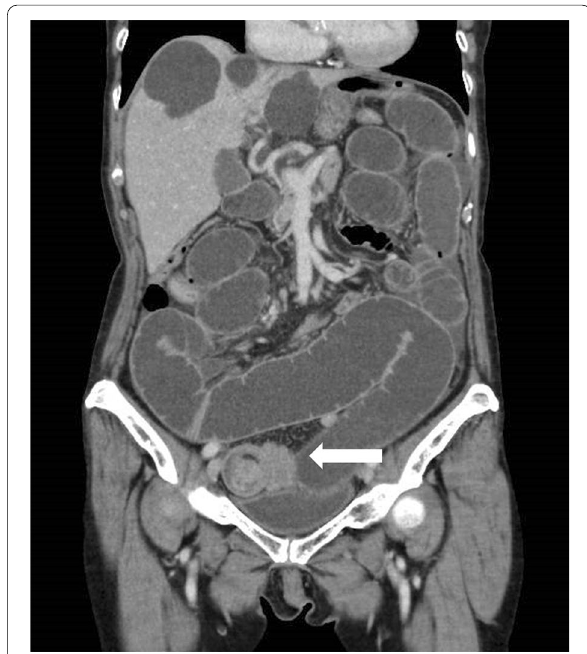
Fig. 1 Late-phase contrast-enhanced CT. Target sign is detected in the small intestine in right lower abdomen (arrow), which indicates intussusception. The small intestine is diffusely dilated. No ascites or intestinal ischemic changes are seen